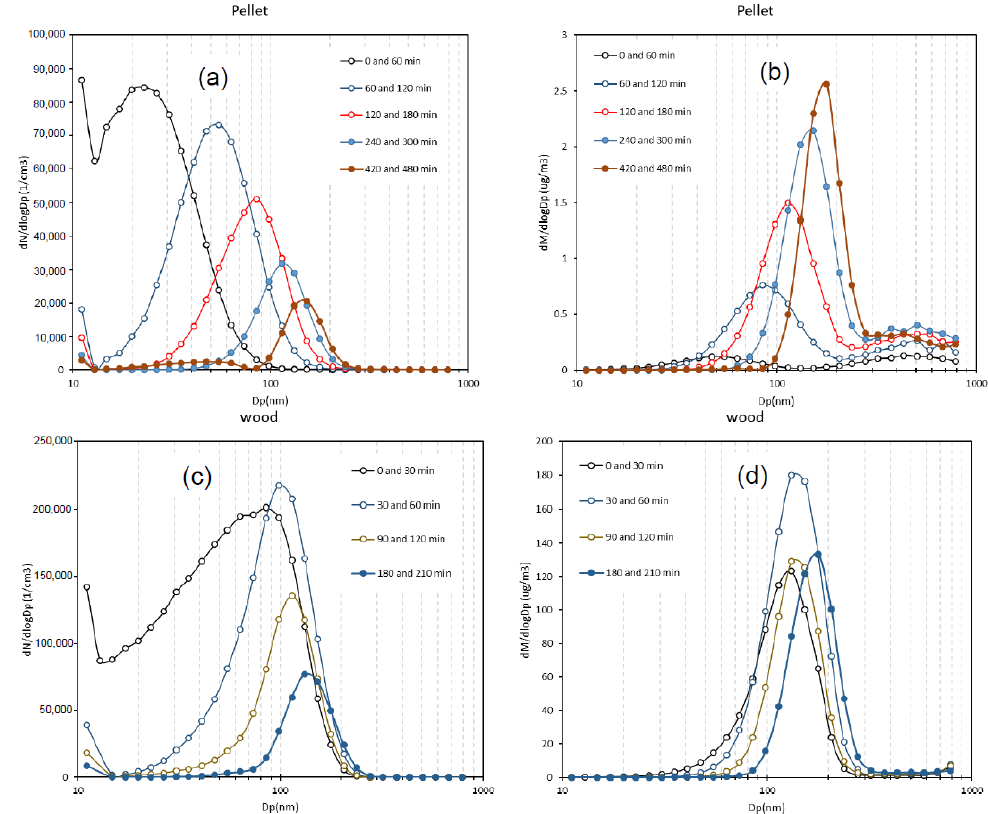
Figure 4. Evolution of particle number ( a ) and ( c ) and mass size distribution ( b ) and ( d ) during the UV irradiation of filtered emissions for pellet (first row) and wood (second row) combustion.